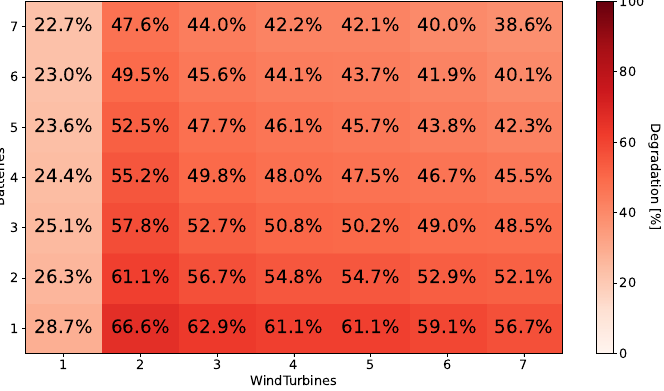
Figure 27. Degradation of the batteries over 20 years of usage with strategy